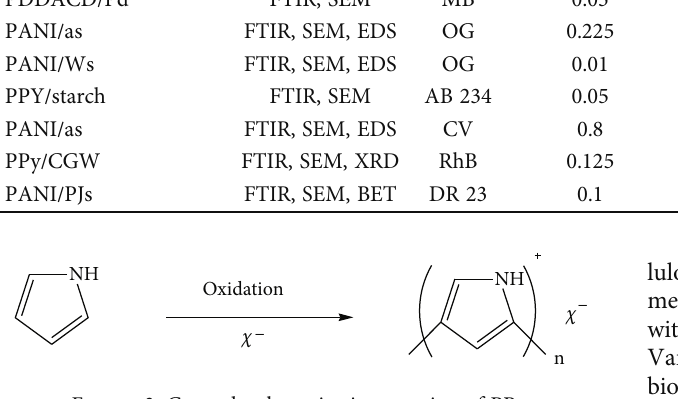
Figure 3: General polymerization reaction of PPy. Table 4: Sensory applications of PPy-based